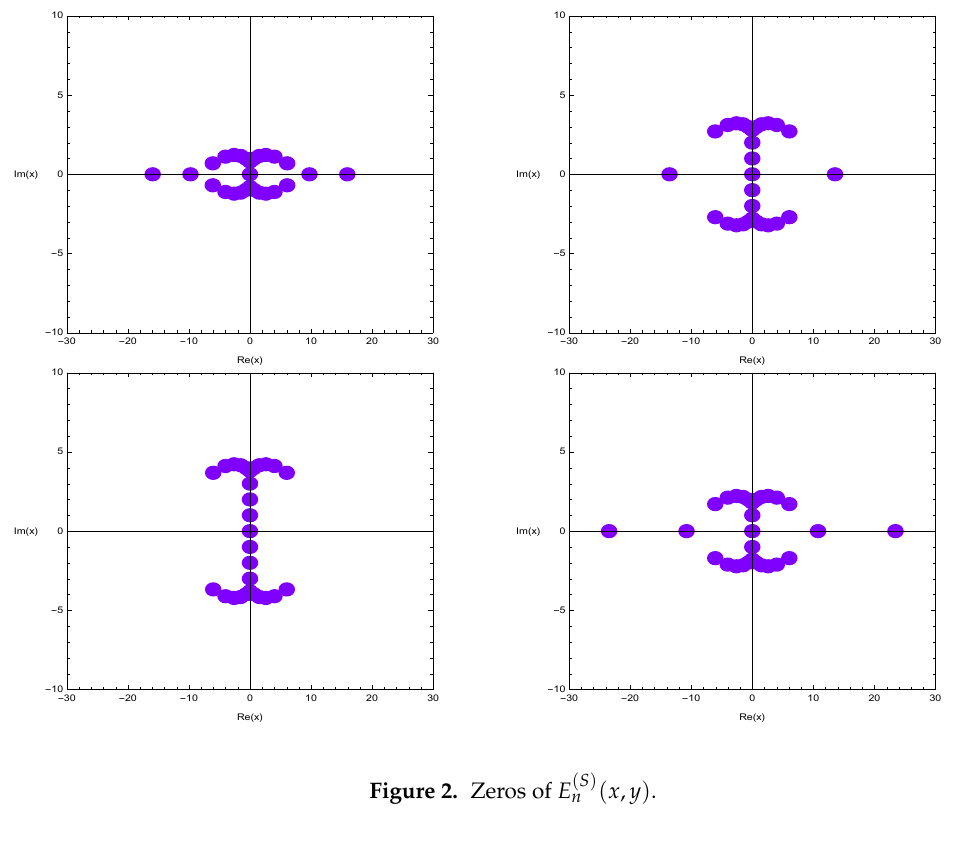
Figure 2. Zeros of E